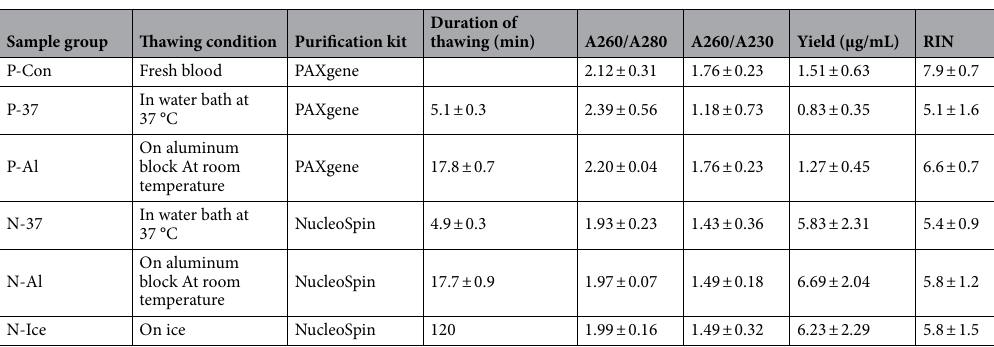
Table 1. Yield and quality of RNA extracted from peripheral whole blood samples using different conditions after short-term storage. Samples were purified after short-term storage (less than 72 h, n = 7). Data are shown as mean ± standard deviation. A 260/280 absorbance ratio at 260 and 280 nm, A 260/230 absorbance ratio at 260 and 230 nm, RIN RNA integrity